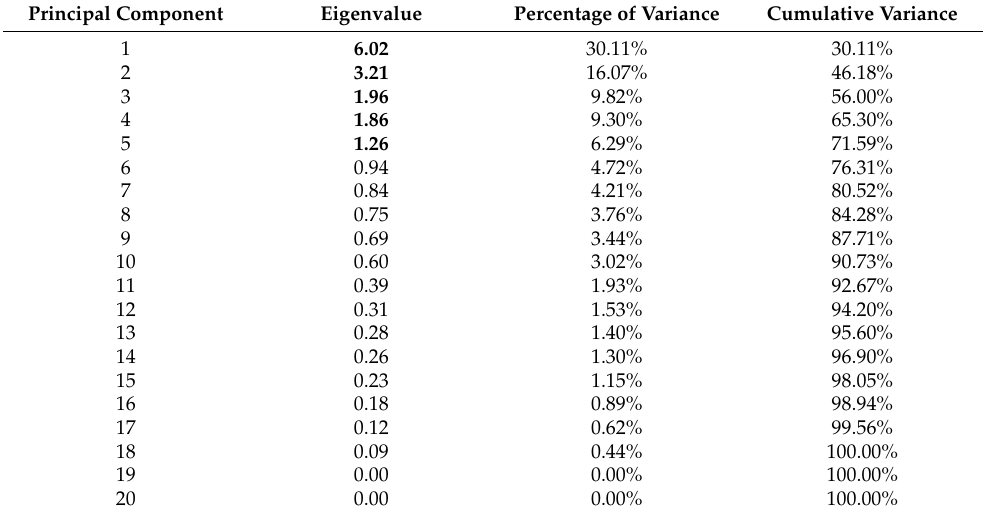
Table A3. Results of a principal components analysis comprising 20 variables (i.e., land use percent Agriculture (Ag;%), Forest (For,%), and Developed (Dev,%)], nutrient concentrations (mg L − 1 ), suspended sediment characteristics [total suspended solids; TSS (mg L − 1 ), mean particle size; MZ ( µ m), calculated surface area; CS (m 2 mL − 1 ), skewness; Ski, Sand (%), Silt (%), and Clay (%)], and physicochemical variables [water temperature (Tw; ◦ C), dissolved oxygen (DO;% saturation), specific conductance (SPC; µ s cm − 1 ), and pH]) used to define five principal components, displaying eigenvalues, percentage of variance, and cumulative variance during the study period (January 2020–December 2021) for eight monitoring sites in Moore’s Run, Watershed, WV, USA. Note: bold numbers indicate Eigen values > 1 (representing importance).